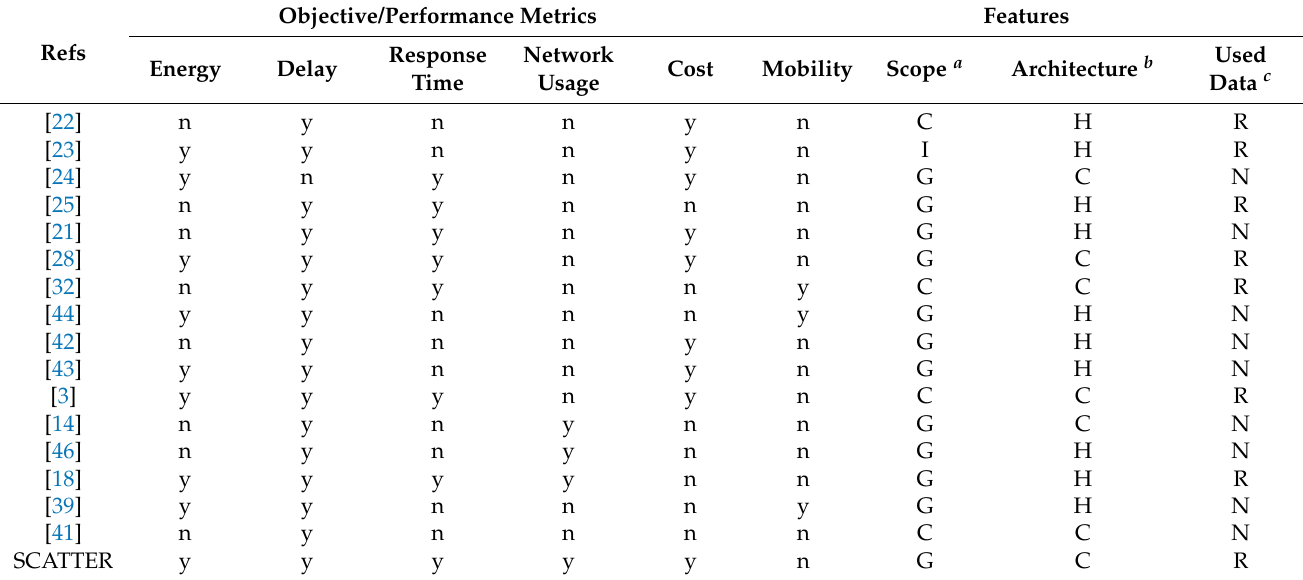
Table 1. Summary of the related works for Service Placement Problem (SPP) in fog-cloud environments.